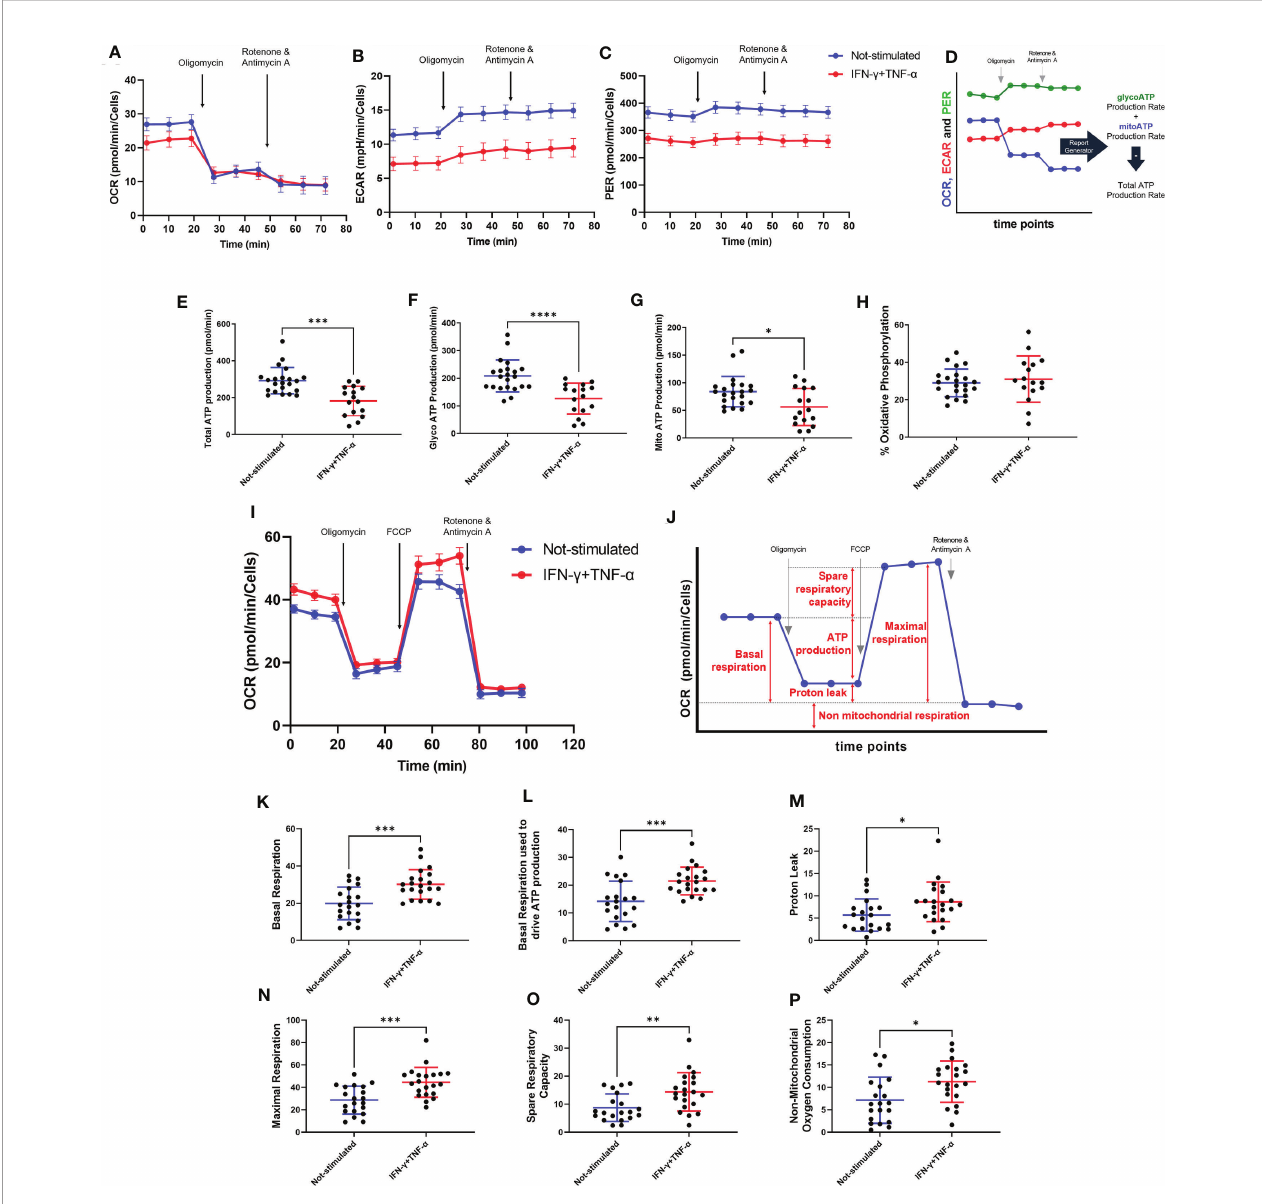
FIGURE 5 | Assessment of AC-16 respiration and ATP production in response to IFN- g and TNF- a stimulation. Oxygen consumption rate (OCR), extracellular acidi fi cation rate (ECAR) and proton Ef fl ux Rate (PER) of 48h IFN- g (10 ng/ml) and TNF- a (5 ng/ml) -stimulated AC-16 cells were obtained in Seahorse XFe24 Analyzer. Arrows show injection of inhibitors of ATP synthase (oligomycin), mitochondrial oxidative phosphorylation uncoupler (FCCP) and OXPHOS complex I and III inhibitors (Rotenone and Antimycin A). (A – C) OCR, ECAR and PER measurement respectively obtained from ATP rate assay. (D) Calculation of mitochondrial and glycolytic ATP. (E – G) Quanti fi cation of total, glycolytic and mitochondrial ATP. (H) Percentage of oxidative phosphorylation. (I) OCR measurement of not-stimulated and cytokines-stimulated cells in the Mitostress test. (J) Representative graph showing the different parameters evaluated, such as (K) basal respiration, (L) basal respiration used to drive ATP production, (M) proton leak, (N) maximal respiration, (O) spare respiratory capacity and (P) non-mitochondrial oxygen consumption. Standard error of the mean in line graphs. Standard deviation is from ≥ 16 independent measurements. *p < 0.05; **p < 0.01; ***p < 0.001; ****p < 0.0001 Mann-Whitney